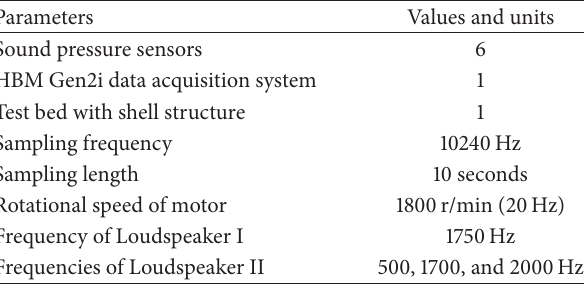
Table 1: The test parameters of the measuring